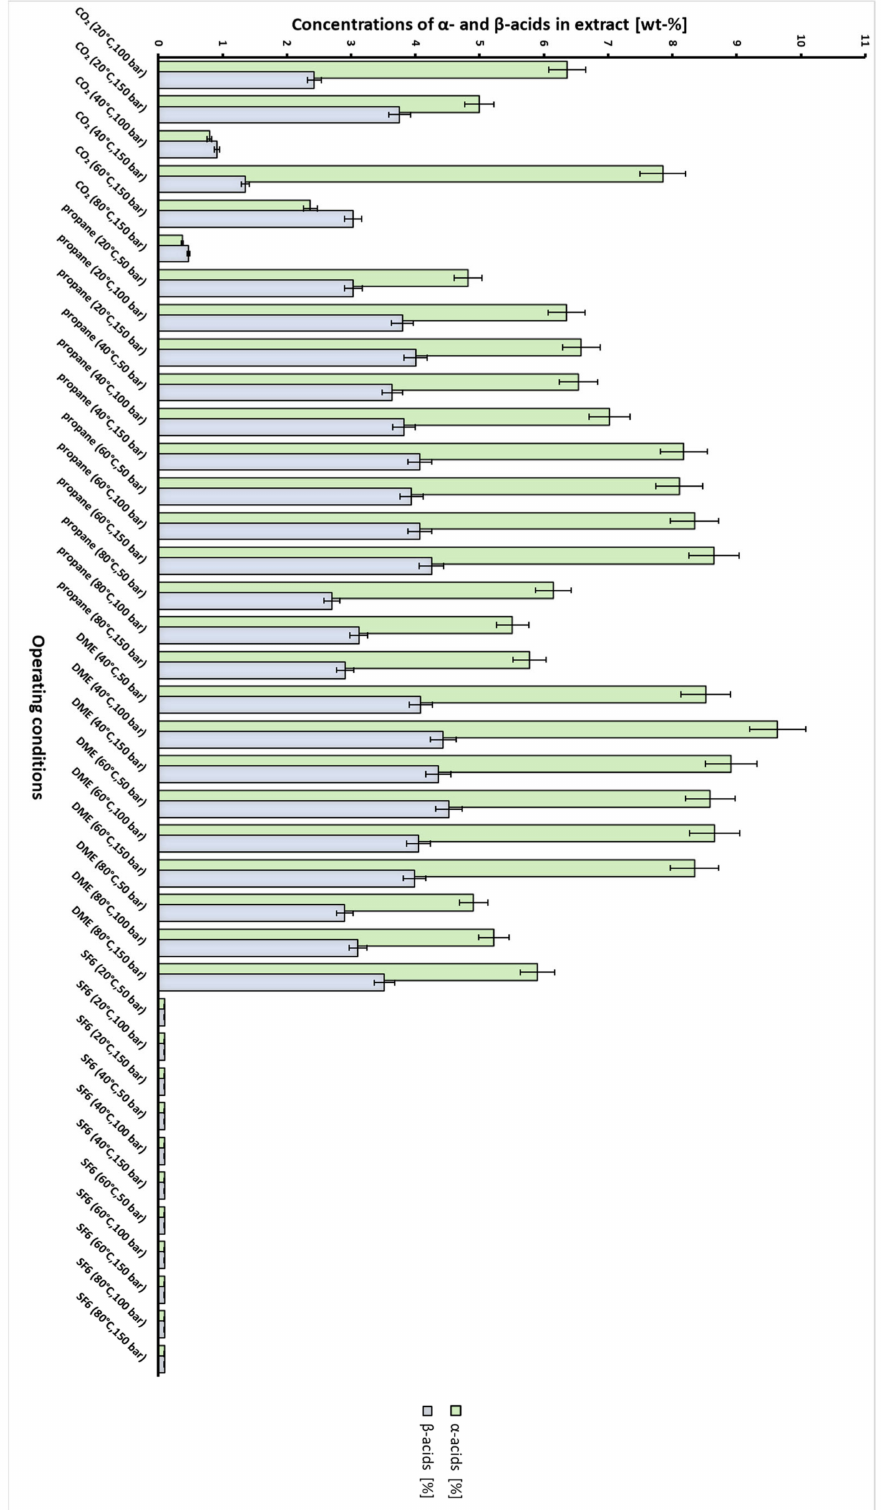
Figure 9. Weight fraction of α - and β -acids in extracts obtained by semicontinuous extraction of hops with dense gases at different operating conditions with standard deviation (SD)